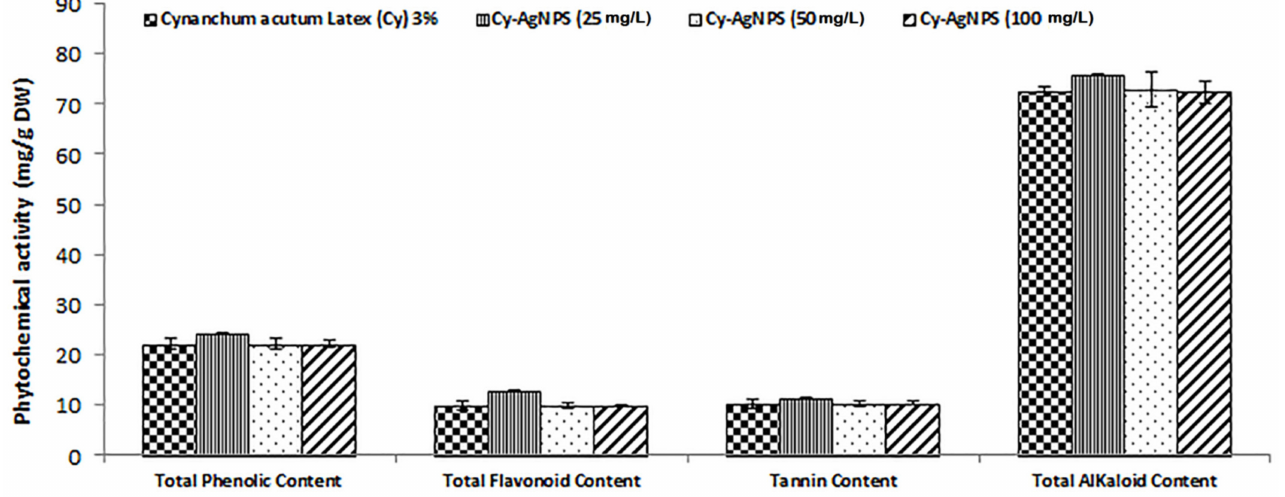
Figure 4. Different bioactive constituents in C. acutum Latex and its different nanoparticle